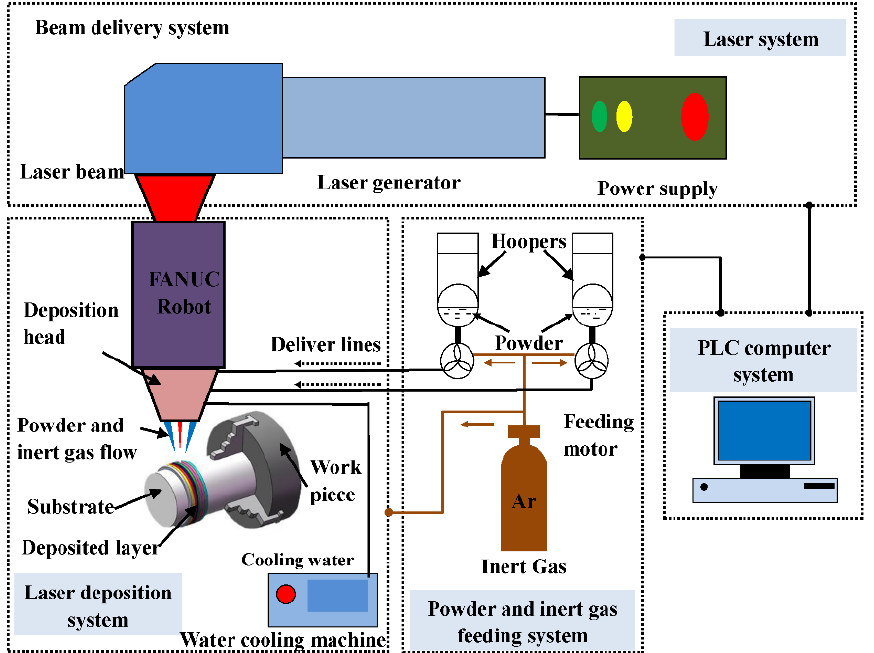
Figure 1. Copyright Elsevier, 2021. The LC process. Reproduced with permission from [33]. Copyright MDPI, 2021.